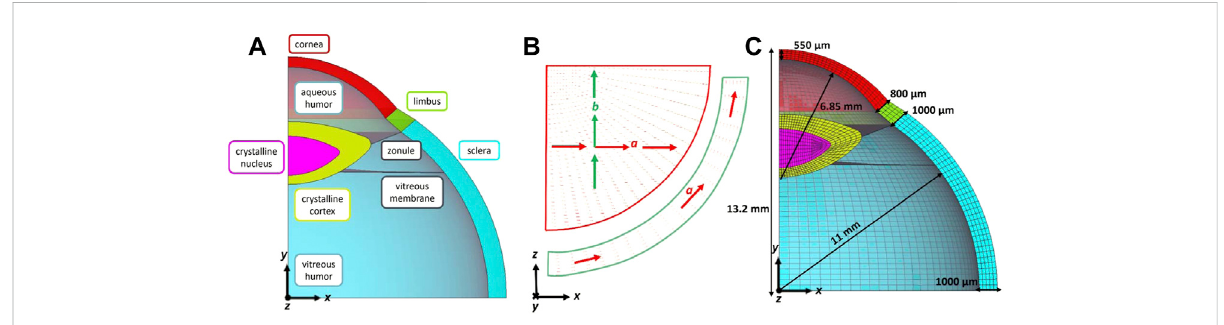
FIGURE 1 (A) Section of the 3D structural parts: cornea, limbus, sclera, crystalline lens nucleus, and cortex, zonule, vitreous membrane, vitreous and aqueous humors; (B) local reference systems de fi ned in each element of the cornea and limbus to model two family of collagen fi bres (A,B) in the corneal plane and one family of fi bres (A) in the tangential direction of the limbus; (C) Hexahedral mesh with fi ve elements in the